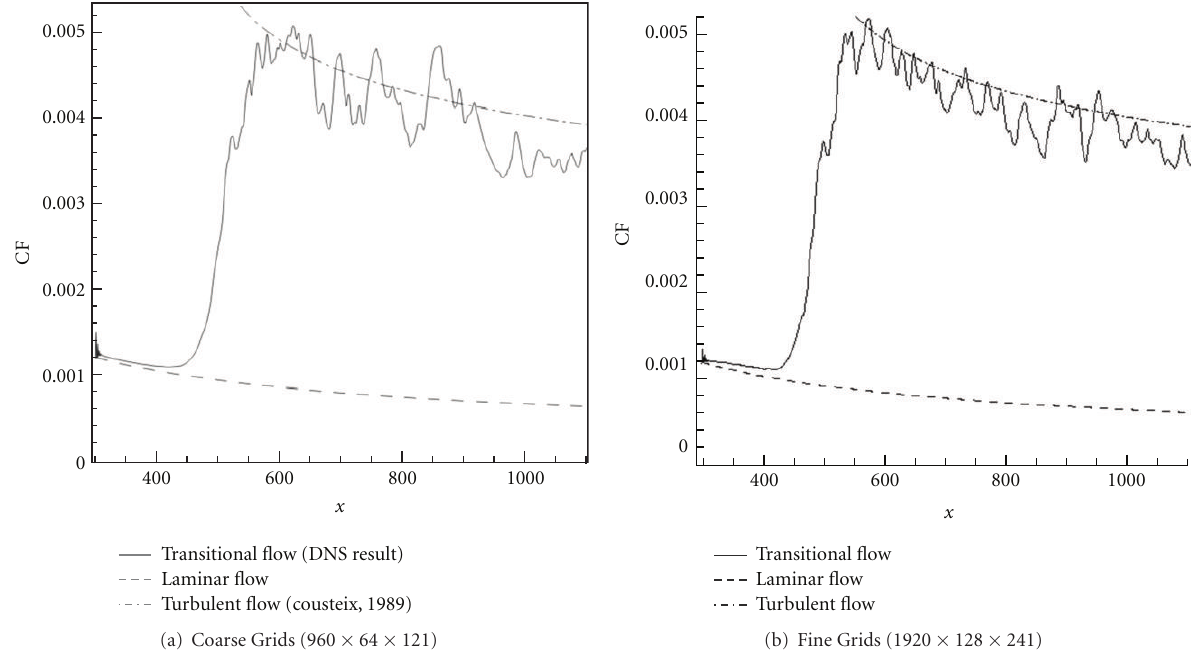
Figure 5: Streamwise evolutions of the time- and spanwise-averaged skin-friction coe ffi cient.